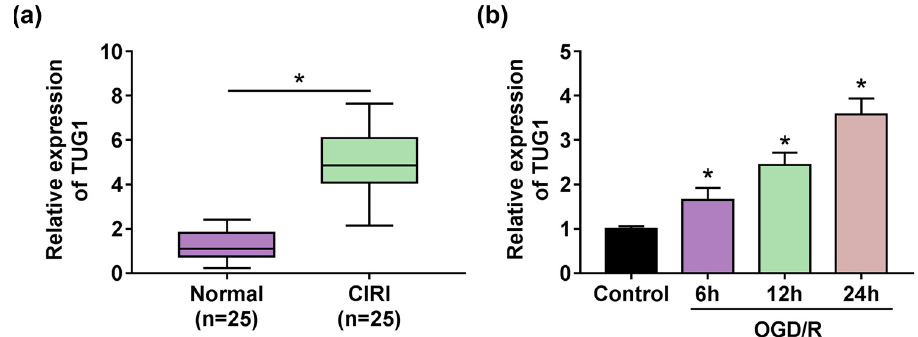
Figure 1: TUG1 was involved in CIRI. ( a ) The expression of TUG1 was measured by RT - qPCR in the serum of CIRI patients ( n = 25 ) and normal people ( n = 25 ) . ( b ) RT - qPCR was devoted to testing the expression of TUG1 in N2a cells with or without OGD/R treatment when the cultivation time reaches 6, 12 and 24 h. * P <